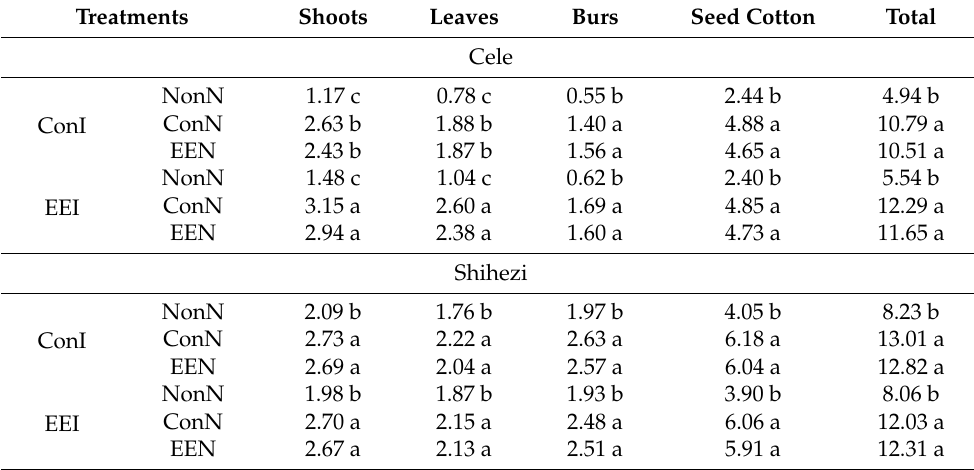
Table 4. Effect of irrigation and nitrogen fertilization strategies on cotton dry matter accumulation (t ha − 1 ). Treatments Shoots Leaves Burs Seed Cotton Total Cele ConI